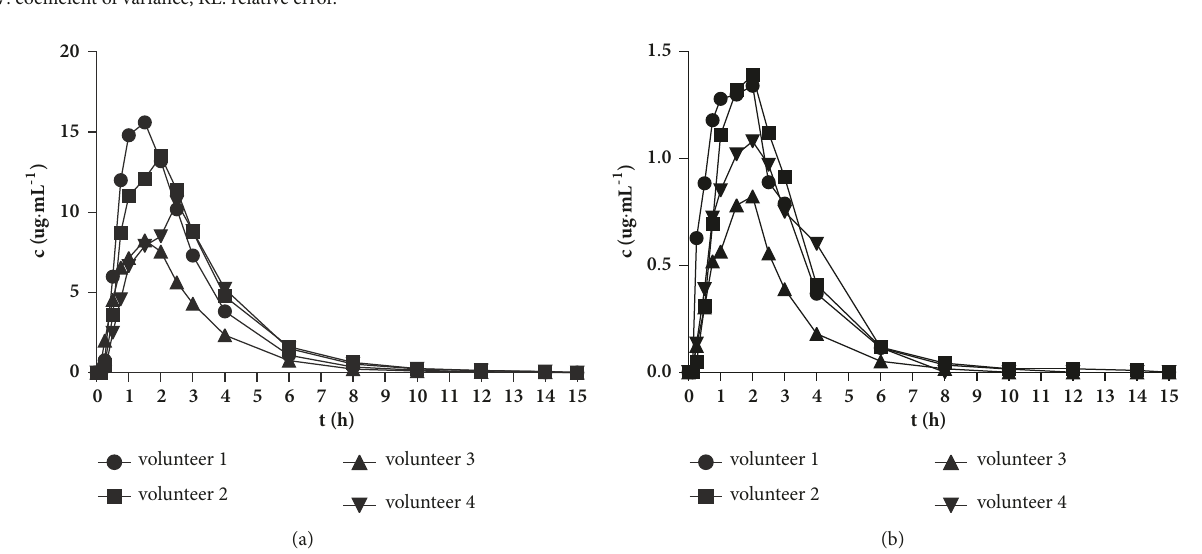
Figure 4: (a) The cis -cefprozil concentration-time curves and (b) the trans -cefprozil concentration-time curves from four healthy Chinese